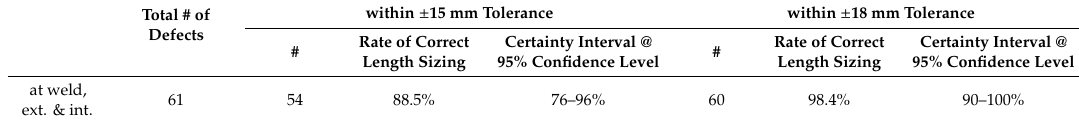
Table 5. Length sizing accuracy of defects at